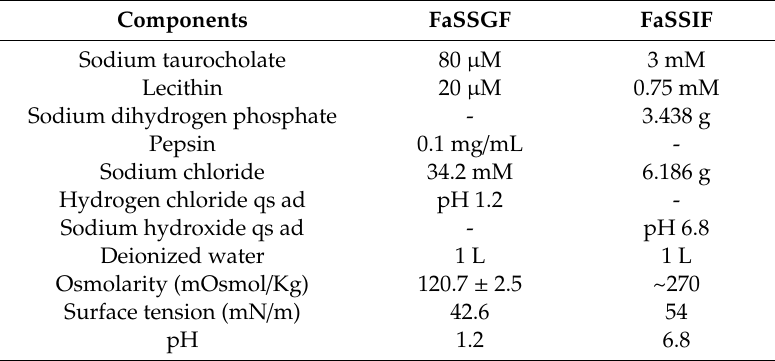
Table 3. Composition of the biorelevant media FaSSGF and